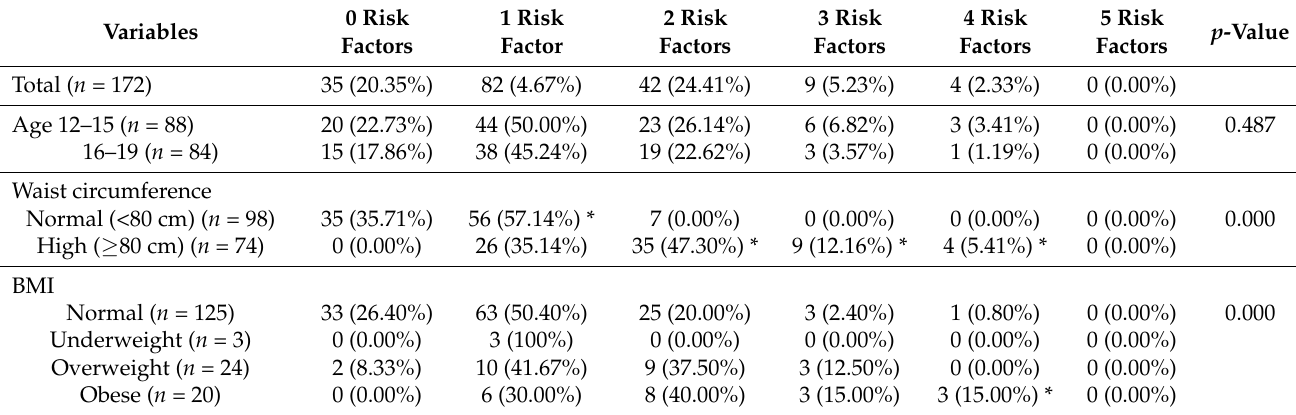
Table 4. Prevalence of the number of MS risk factors by age, waist circumference, and BMI